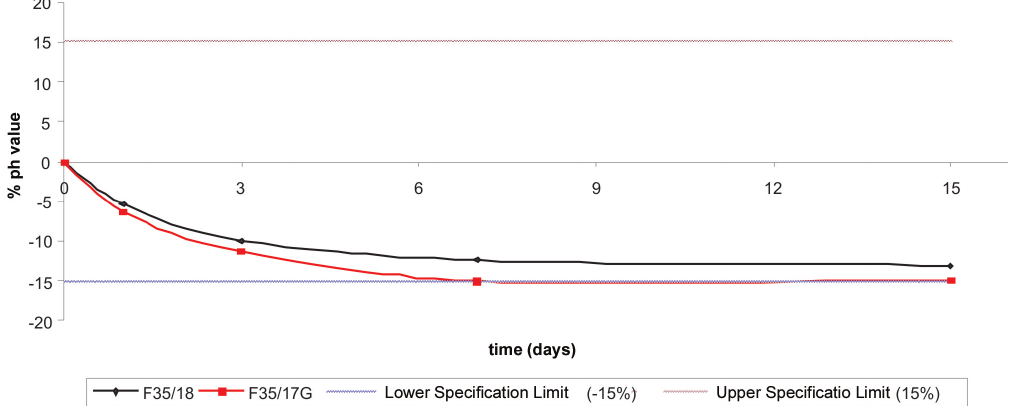
FIGURE 2 - Percentage variation of pH value for the test formulations F35/18 and F35/17G in the Oven (45.0 ± 2.0 ºC) storage condition in the Accelerated Stability Study.